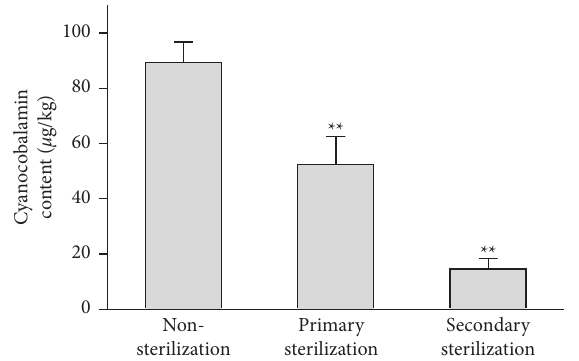
Figure 2: Cyanocobalamin content by the production process in medical food. The medical food was sterilized twice (primary sterilization, 135 ° C, 72s; secondary sterilization, 124 ° C, 10min) ( ∗ p < 0 . 05 and ∗∗ p < 0 . 01 versus the nonsterilized sample; one-way ANOVA followed by Tukey’s post hoc